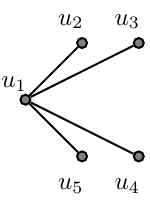
Figure 7: The graph G